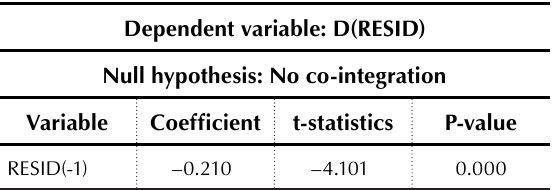
Table 5. Results of Philips - Ouliaris